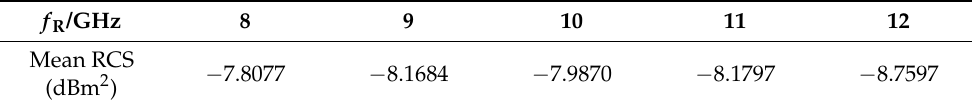
Figure 6. Dynamic RCS of rotor 1 at different f RH , α = 30°, β = 5°, n r1 = 1200 r/min. Table 3. Dynamic RCS mean of rotor 1 at different f RH , α = 30°, β = 5°, n r1 = 1200 r/min.